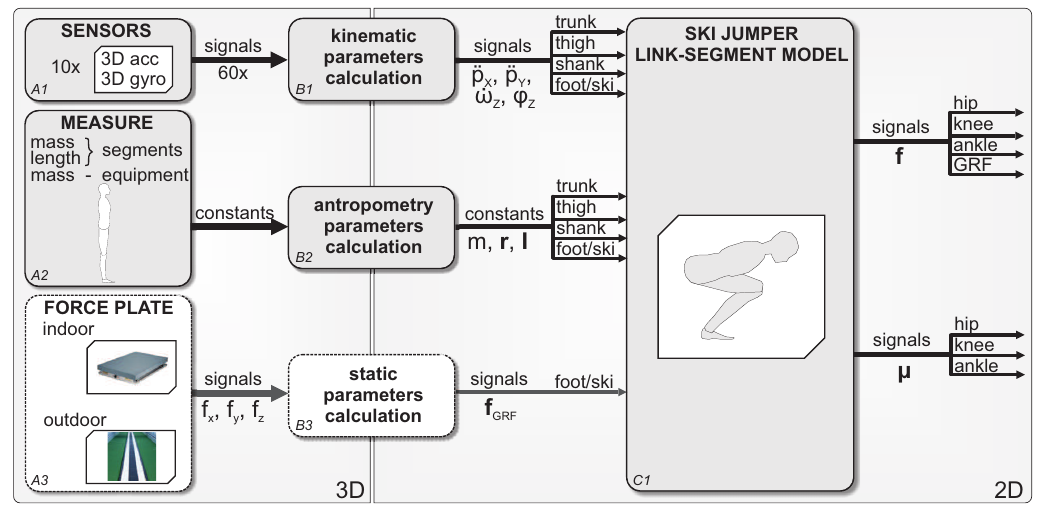
Figure 2. Data flow for measurement data processing. ( A1 ) The acceleration and angular velocity of each IMU are obtained; ( A2 ) The ski jumpers anthropometric data and equipment are measured; ( A3 ) Measuring ground reaction force (GRF) from a force platform; ( B1 ) Kinematic and ( B2 ) anthropometric parameter calculation; ( C1 ) The ski jumper link-segment model